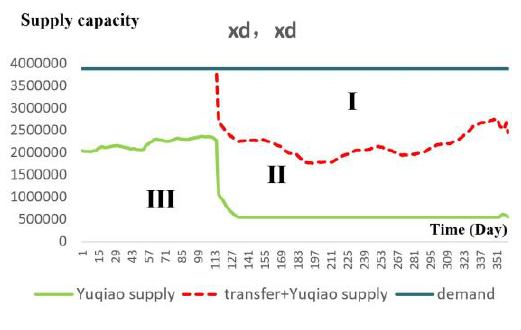
Figure 10. Case of (xd, xd).